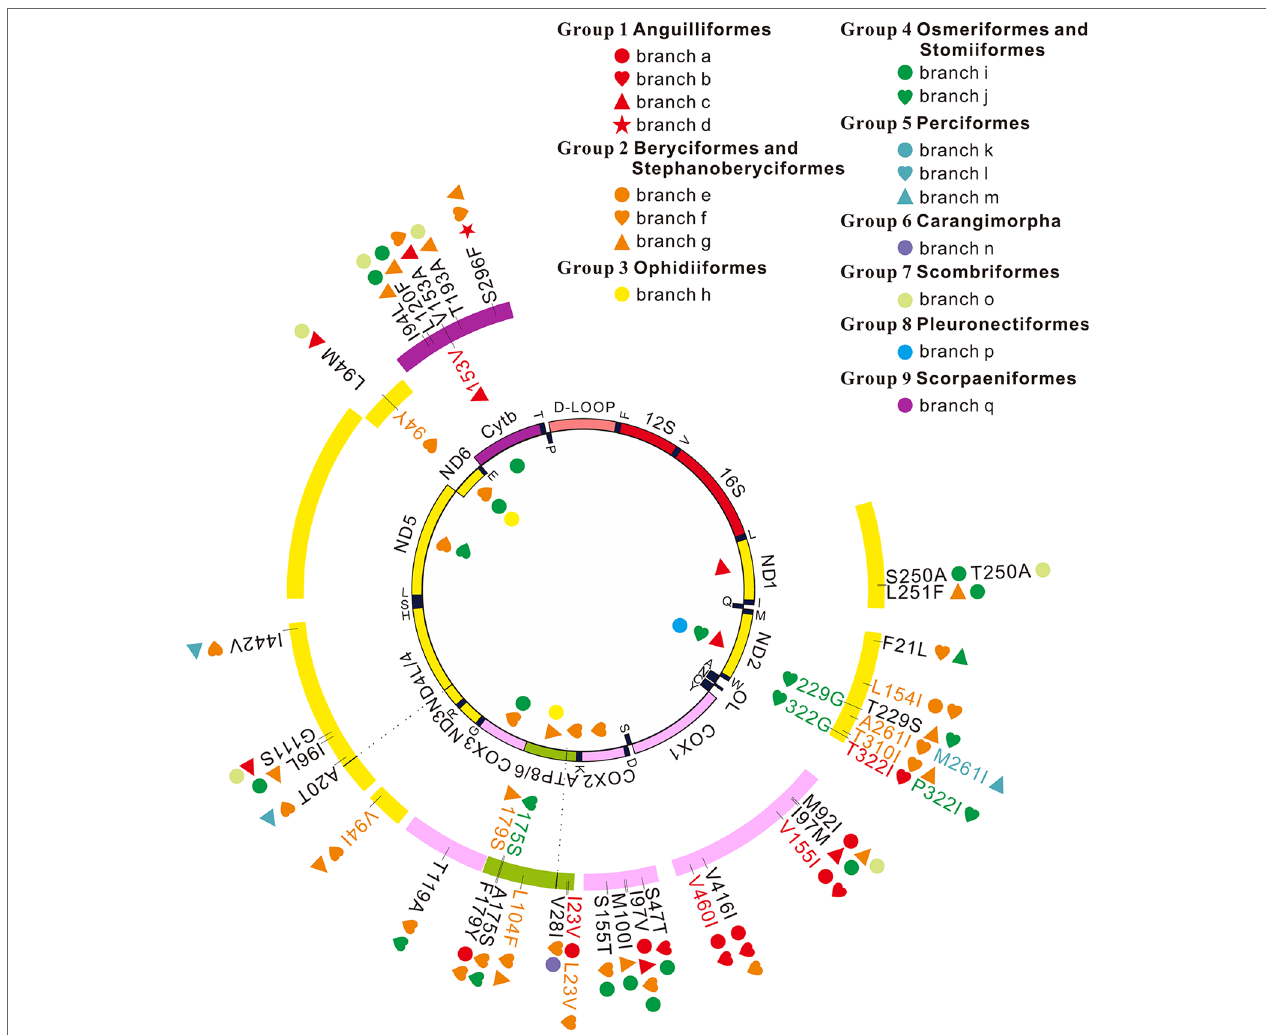
FIGURE 2 | Positive selection and convergent/parallel evolution on 13 mitochondrial protein-coding genes in deep-sea fishes. Symbols inside the interior track denote signals of positive selection and symbols inside the outer track represent those sites that have both signals of positive selection and convergent/parallel evolution. Symbols outside the outer track show convergent/parallel amino acid